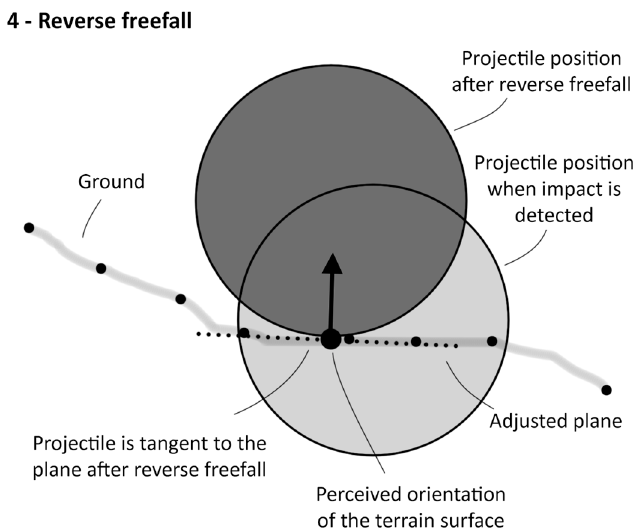
Figure 9. Algorithm step 4. The impact’s location is adjusted by reverting the freefall preceding step 3 (Figure 6c) until the rock is tangent to the surface. In this figure, the perceived surface is the best fitted plane of the points identified in a radius of ½ d 1 from the last point to be tangent to the rock when reverting the freefall. If the fit is bad or if a tree is impacted, then the last tangent point is simply used as the local surface.